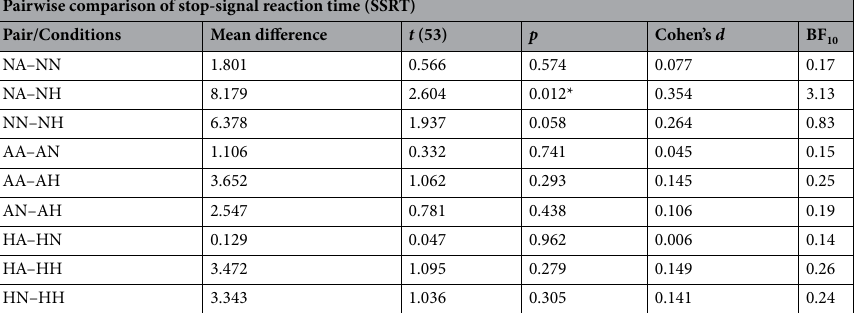
Table 2. AA, AN, AH; NA, NN, NH; HA, HN, HH respectively correspond to angry-angry, angry-neutral, angry-happy; neutral-angry, neutral–neutral, neutral-happy; happy-angry, happy-neutral, happy-happy. Here first emotion is the emotion of the go signal and the second emotion is the emotion of the stop signal. * p < 0.05.